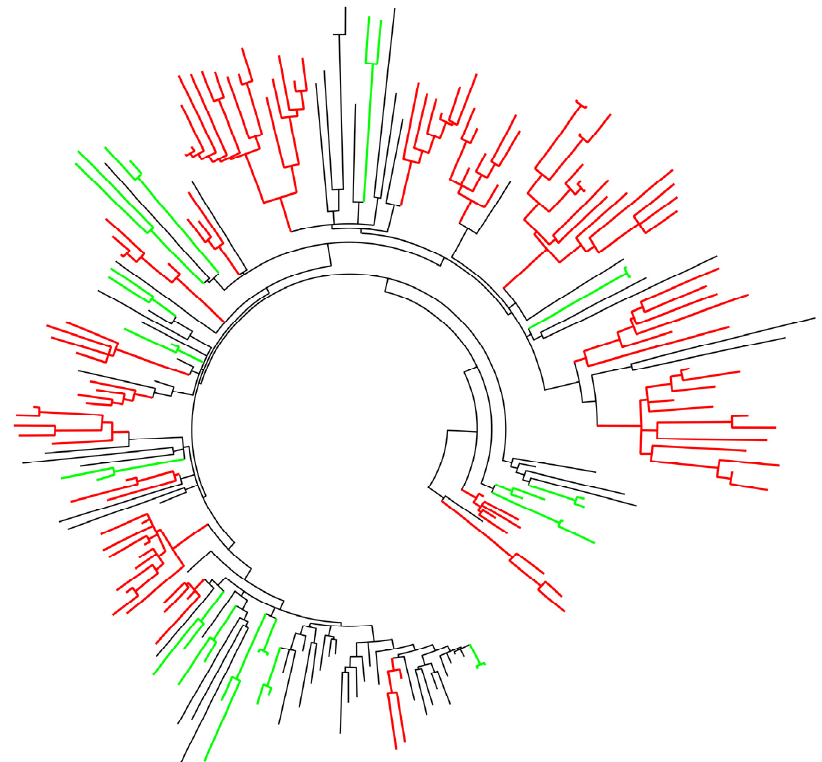
Figure 2. ML phylogenetic tree based on 198 HIV subtype B pol sequences sampled from 2006 to 2020 in St. Petersburg; tree was constructed in MEGA software under the GTR + G + I nucleotide substitution model. Transmission clusters are labeled in red. Transmission pairs are mark in green.